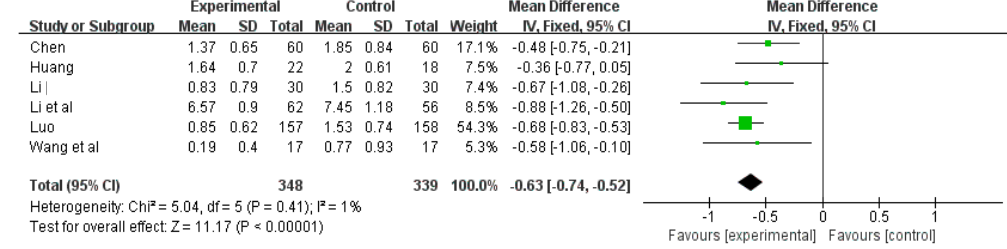
Figure 6. Forest plot of sleep time effect size.